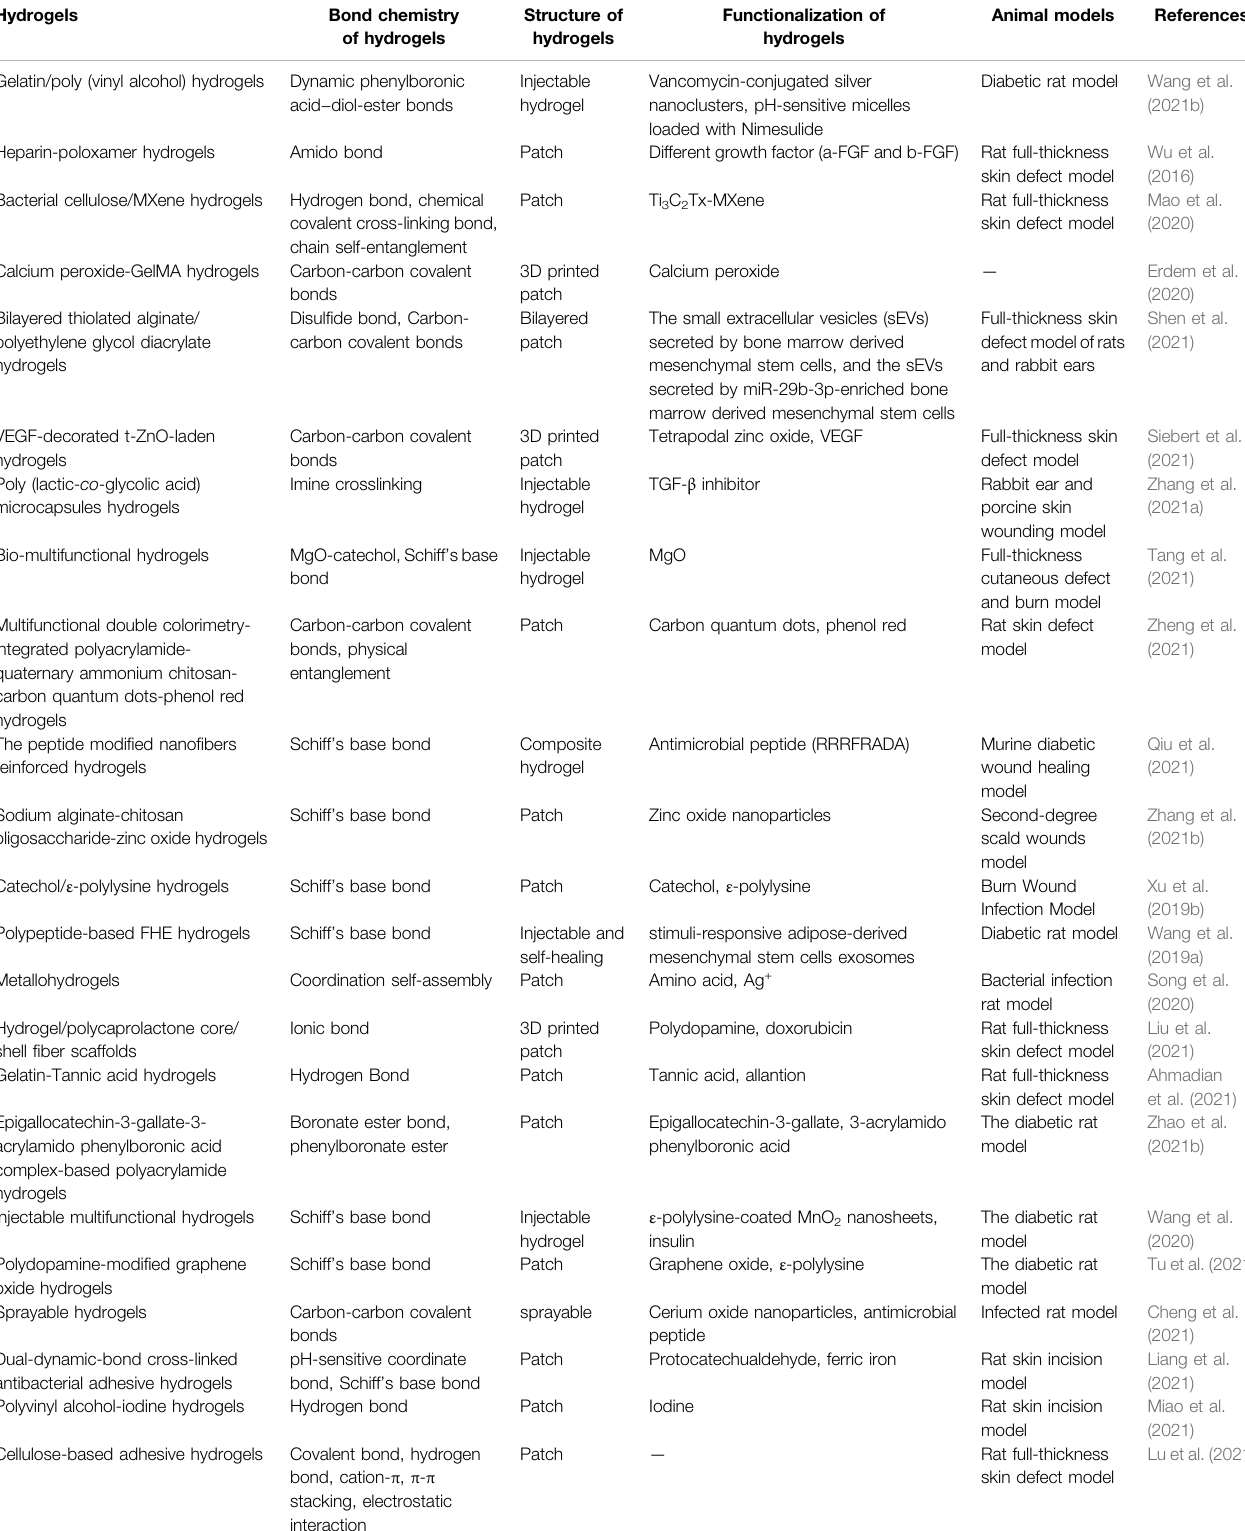
TABLE 1 | Functional hydrogels for skin wound healing.